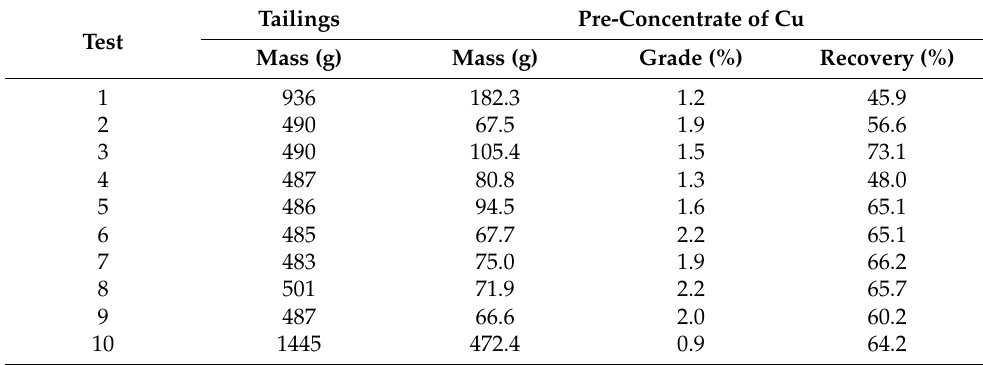
Table 4. Results of the performed flotation tests for copper oxides and sulfides. For Test 1, 1 kg of